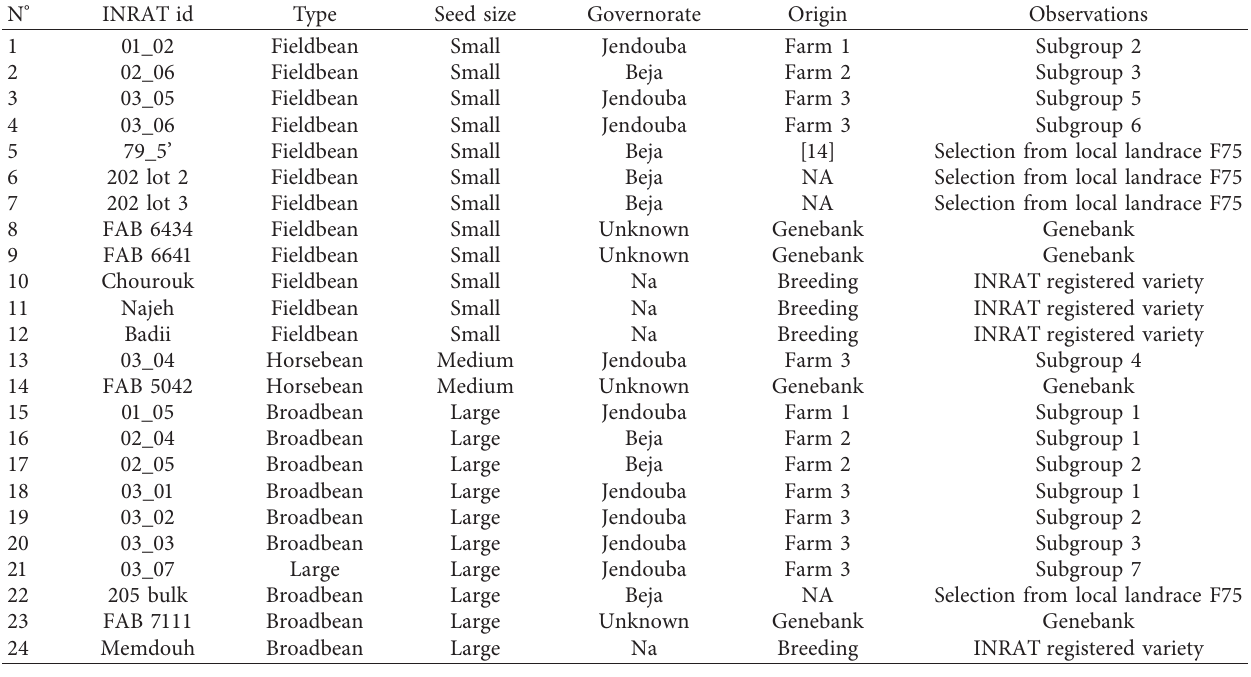
Table 1: List of collected landraces and local populations of Vicia faba L. and their origins. N ° INRAT id